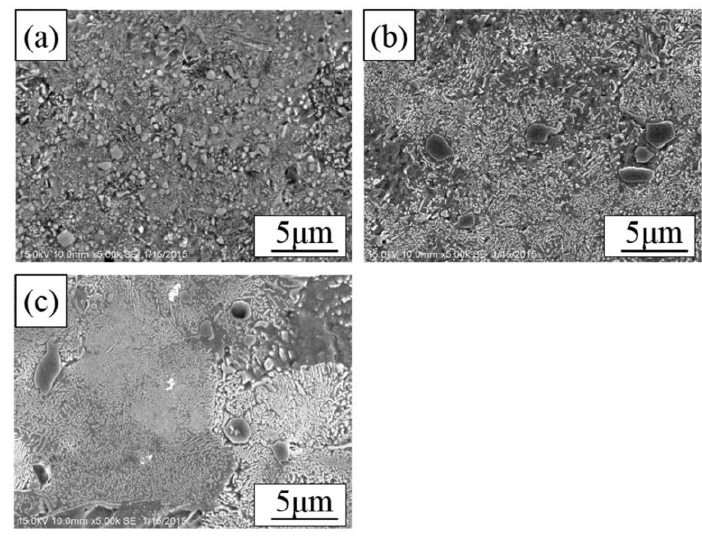
Figure 4. Microstructure of the as-received modified 440A MSS which were taken from ( a ) edge; ( b ) quarter; and ( c ) center areas, respectively.